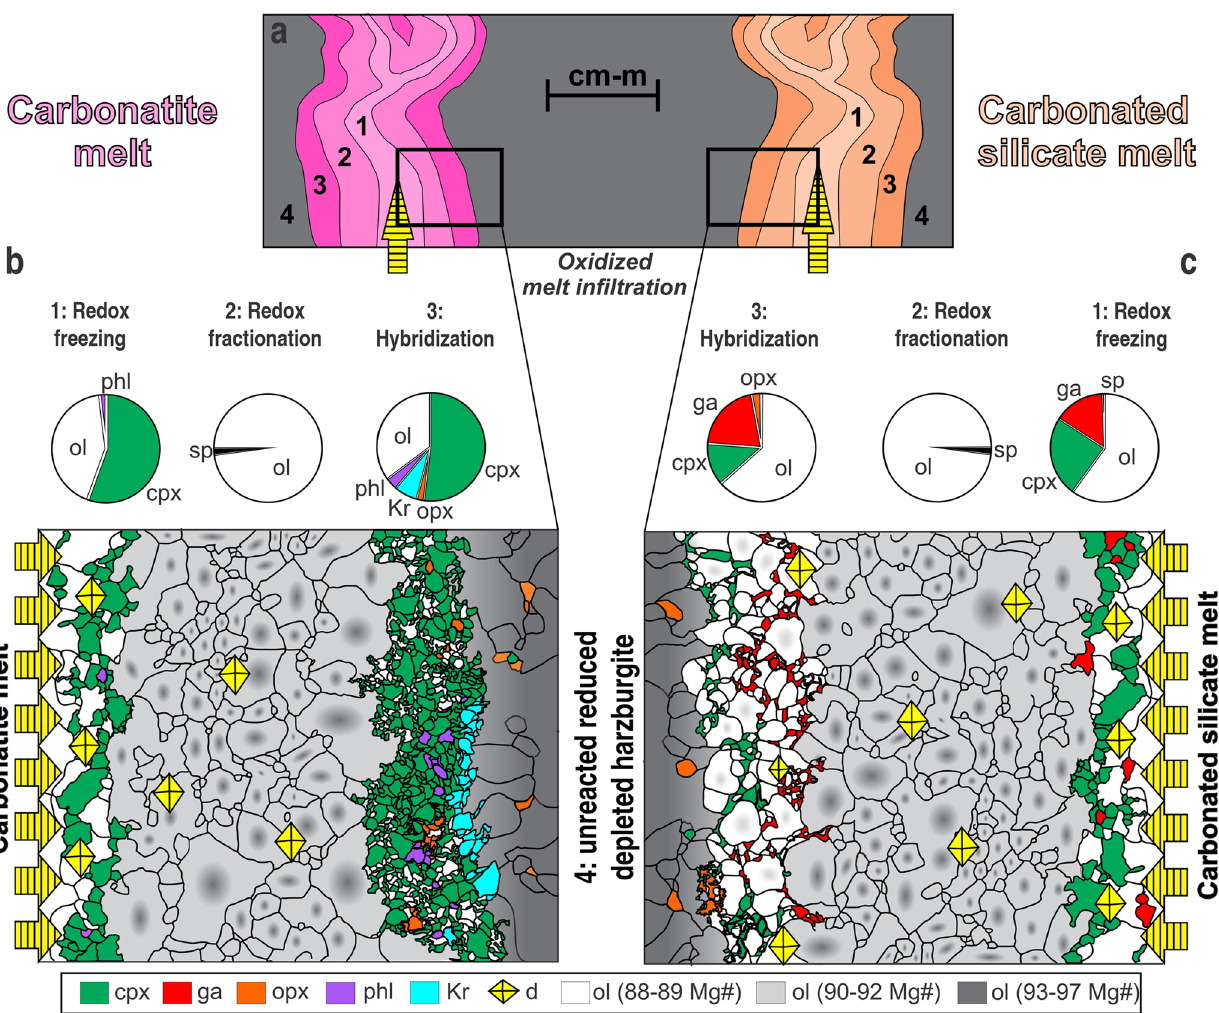
Fig. 2 Experimental results showing the effects of incipient melt in fi ltration into reduced, peridotite. a Stylized reaction zones resulting from redox freezing, reactive melt in fi ltration, and hybridization by carbonatite b and carbonated silicate incipient melts c (based on microprobe maps, see Suppl. Figs. 3 and 4). Modal proportions in each reaction zone are illustrated as pie charts highlighting the modal enrichment in clinopyroxene and other silicate minerals. Silicate phases are shown in colors (see key at bottom). Yellow diamond symbols represent (metastable) graphite precipitation in experiments (equivalent to diamonds in the lower